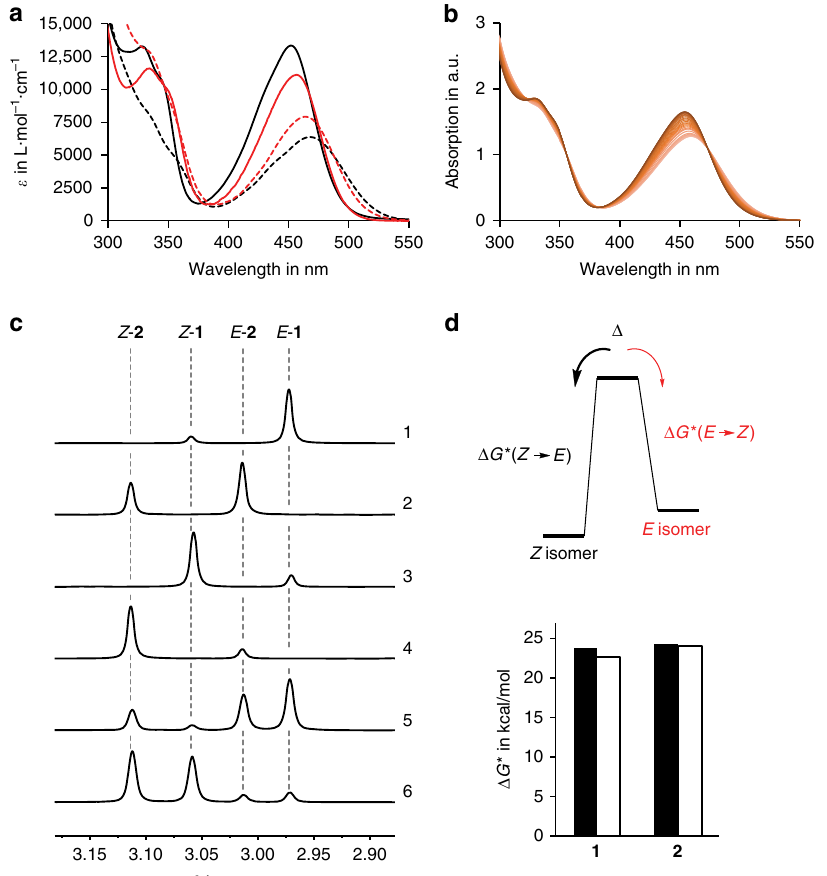
Fig. 3 Switching behavior of HTI tweezers 1 and 2 . a Molar extinction coef fi cients of 1 (black) and 2 (red) in CHCl 3 . The Z isomers are shown in solid lines and E isomers in dashed lines. b Reversible absorption changes observed during irradiation of a 1:1 mixture of 1 and 2 in CHCl 3 with 435 nm and 530 nm light. c Indicative section (signals of the methylene groups) of the 1 H NMR spectra of 1 and 2 in CDCl 3 solution at 27 °C after reaching the pss at two different wavelengths. 1. 86% E - 1 are obtained at 435 nm. 2. 63% E - 2 are obtained at 435 nm. 3. 80% Z - 1 are obtained at 530 nm. 4. 84% Z - 2 are obtained at 530 nm. 5. Essentially the same pss composition as for the individual tweezers is obtained for a 1:1 mixture of 1 and 2 at 435 nm. 6. Essentially the same pss composition as for the individual tweezers is obtained for a 1:1 mixture of 1 and 2 at 530 nm. d Free activation enthalpies for the thermal E to Z (solid bars) and Z to E (hollow bars) equilibrations of 1 and 2 in CDCl 3 in the dark. Energy values range from 22.7 to 24.4 kcal mol −